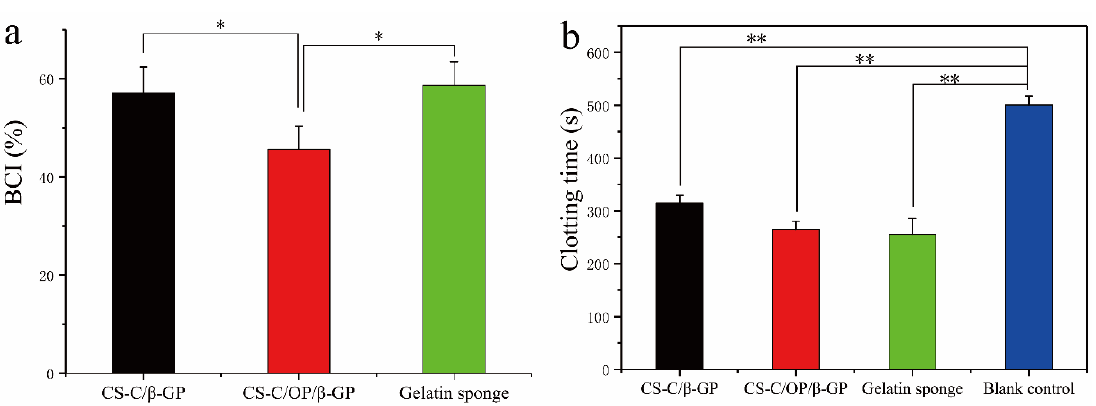
Figure 2. Blood coagulation index ( a ) and clotting time ( b ) in vitro, * p < 0.05 and ** p < 0.01.